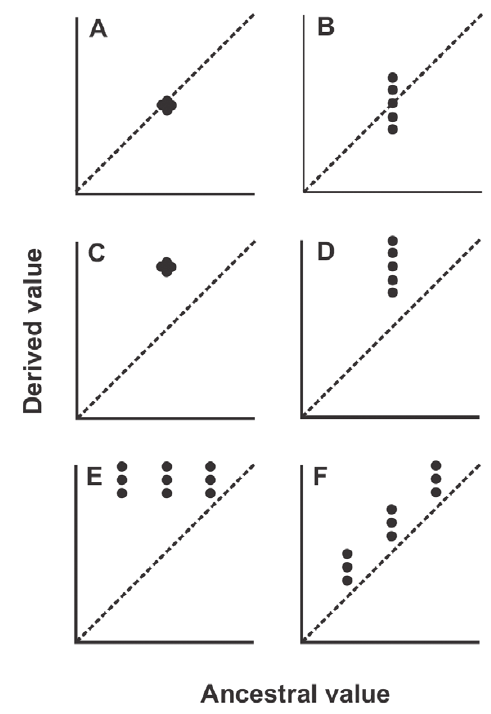
Figure 3 - Schematic representation of changes related to adaptation, chance, and history in the evolutionary paths (Travisano et al. 1995a: 87). A) No change, no evolution; B) Chance plays a major role, the mean of the derived values are around the same value as the ancestral; C) Adaptation plays a major role, the derived values are higher and closely associated; D) Adaptation plays a role, but is combined with chance to spread the values; E) An initial effect due to history is eliminated by subsequent adaptation and chance effects; F) An initial effect due to history is maintained, chance and adaptation are